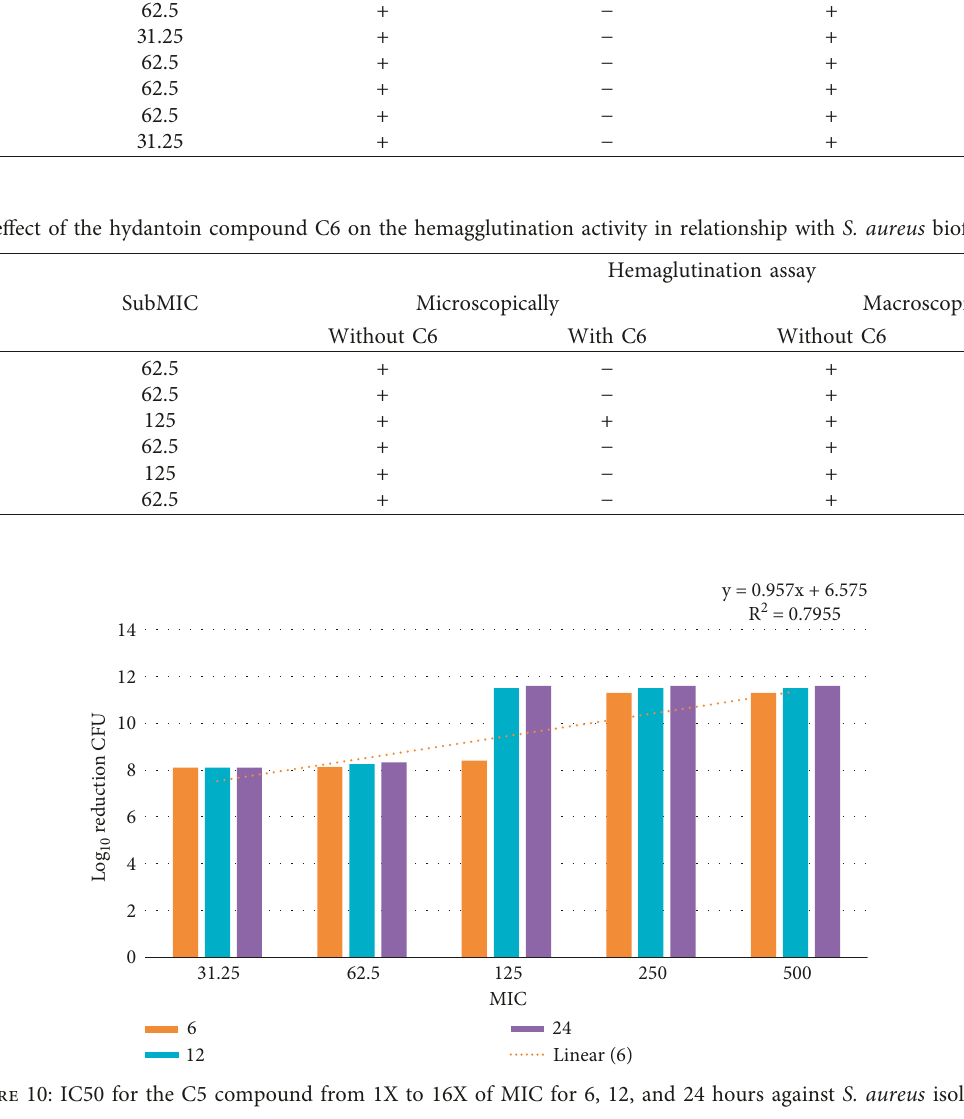
Table 12: Effect of the hydantoin compound C5 on hemagglutination activity in relationship with S. aureus biofilm formation. Hemaglutination assay No. of isolates SubMIC Microscopically Macroscopically